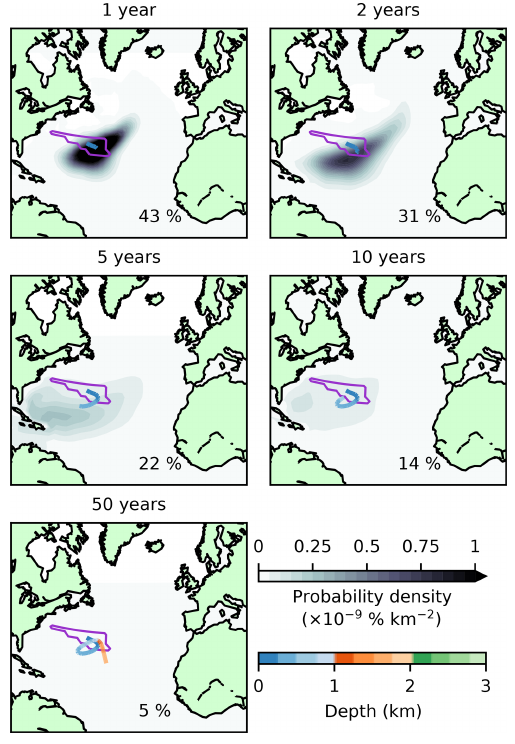
Figure 6. Evolution of NASMW-tagged tracer in the tangent-linear model. Black and white shading indicates depth-integrated prob- ability density (corresponding to the likelihood that NASMW is found in that region) at 1, 2, 5, 10, and 50 years. Inset percent- ages show the global integral of this field, i.e. the total proportion of tracer not yet re-ventilated at the surface. The coloured line tracks the centre of mass of the tracer from initialisation to its current posi- tion, with colours indicating the mean depth of the tracer. The purple contour shows the distribution of the original tracer